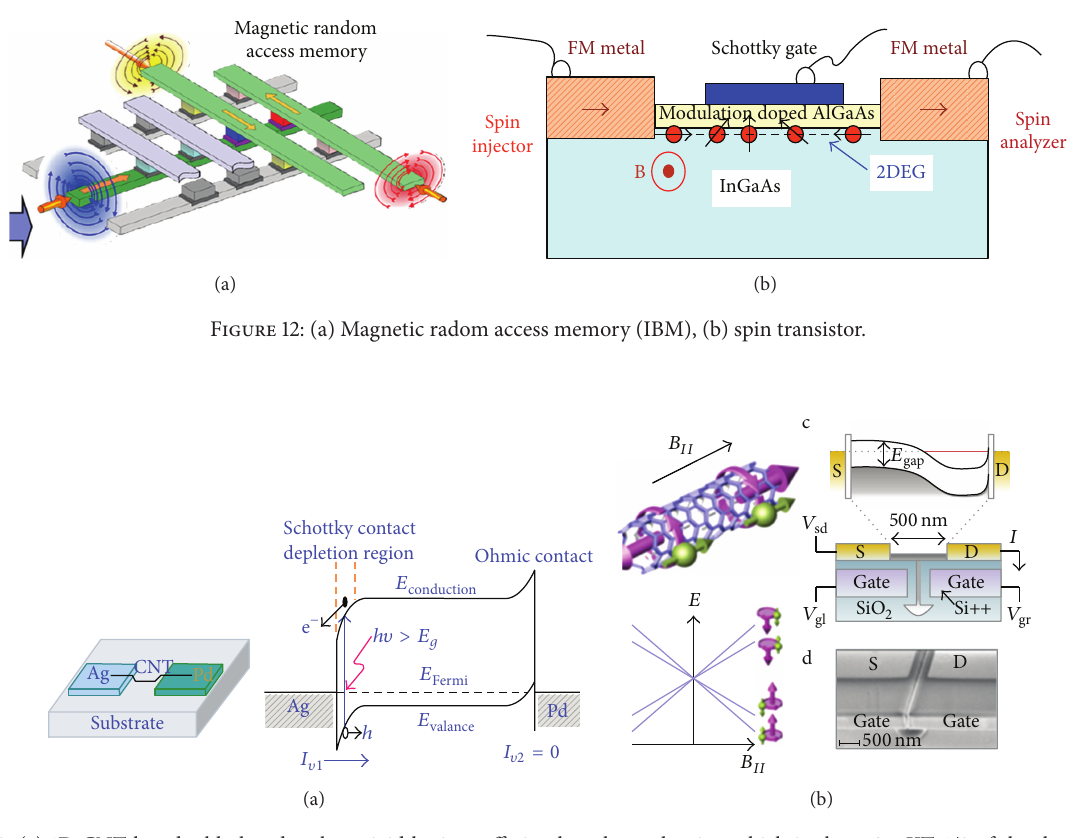
Figure 13: (a) 1D CNT has double-bond carbon rigid lattice suffering less thermal noise, which is about 0.5 KT, 1/3 of the thermal noise of CCD dark current liquid nitrogen coolant (LNC). (b) Axial magnetic field increases the surface area as the phase space and avoids the collision recombination of photoelectric carriers (after Rice, Cornel Univ).